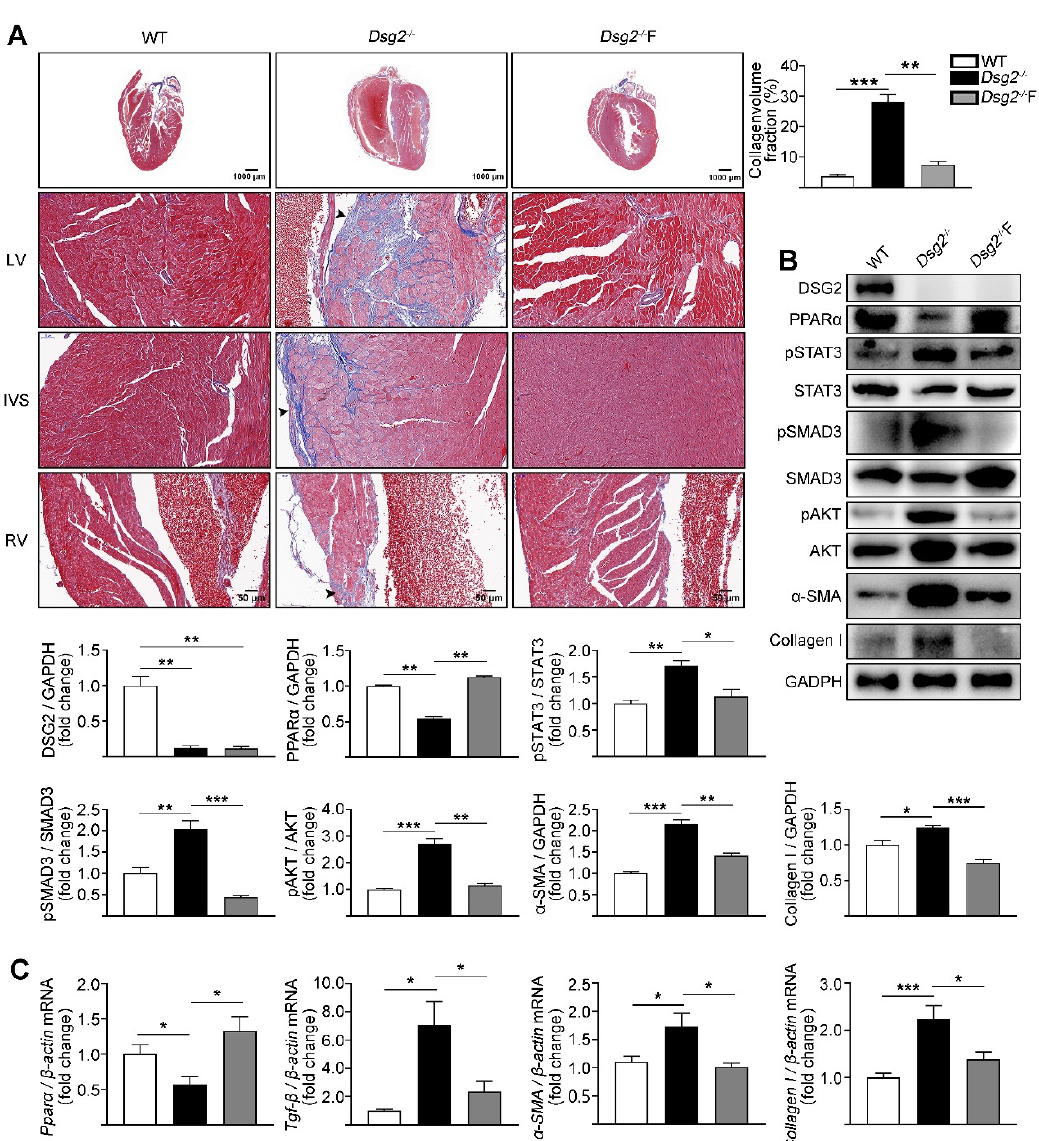
Figure 3. Fenofibrate alleviated cardiac fibrosis in CS-Dsg2 − / − mice. ( A ) Masson staining of heart sections in WT, CS-Dsg2 − / − mice, and CS-Dsg2 − / − mice treated with fenofibrate (Dsg2 − / − F). Collagen volume fraction in the hearts of WT, CS-Dsg2 − / − , and Dsg2 − / − F mice were assessed. ( B ) Representative Western blots from ventricles of WT, CS-Dsg2 − / − , and Dsg2 − / − F mice. DSG2, PPAR α , pSTAT3, pSMAD3, pAKT, α -SMA, and Collagen I were detected using specific antibodies. STAT3, SMAD3, AKT, and GAPDH were used as loading controls. ( C ) Results of quantitative PCR analysis of PPAR α , TGF- β , α -SMA, and Collagen I mRNA levels in mouse ventricles are expressed as fold change of control using β -actin as loading control. Results are expressed as mean values ± SEM. n = 6. * p < 0.05, ** p < 0.01, *** p < 0.001 vs. control.